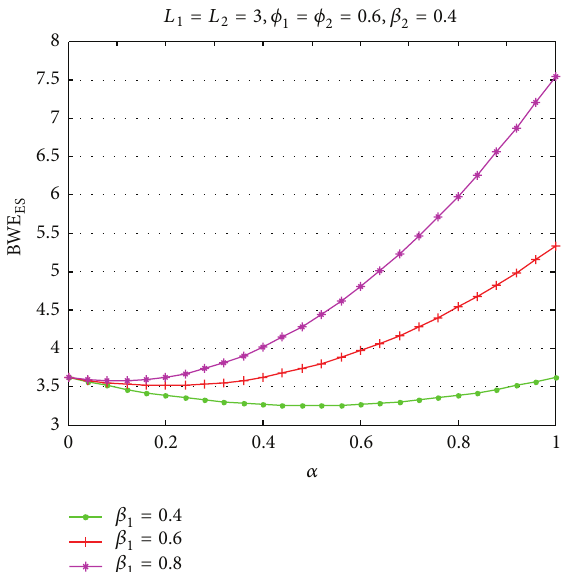
Figure 14: Impact of 𝜙 1 on bullwhip effect for different 𝐿 1 under the